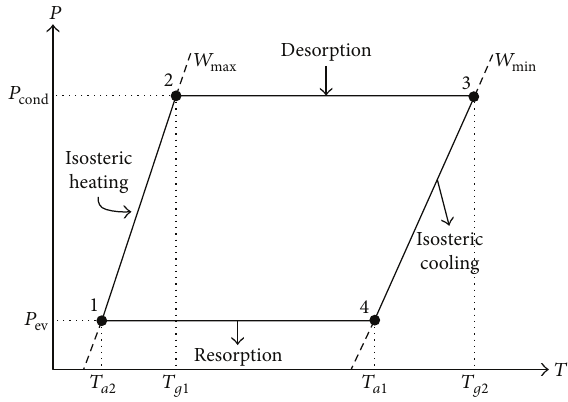
Figure 1: P-T-W diagram of the basic adsorption cycle [14].